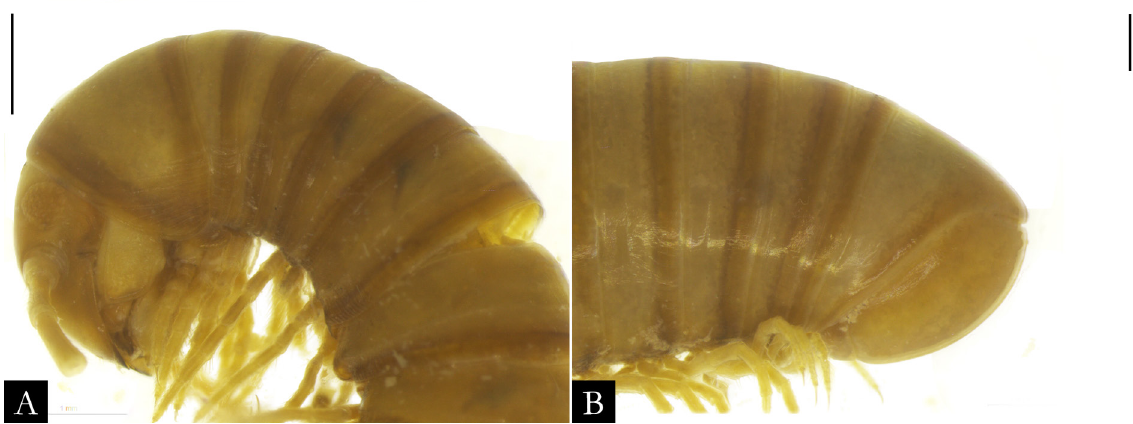
Fig. 132. Pseudonannolene tocaiensis Fontanetti, 1996, paratype, ♂ (MZSP 942), in lateral view. A . Anterior region. B . Posterior region. Scale bars = 1